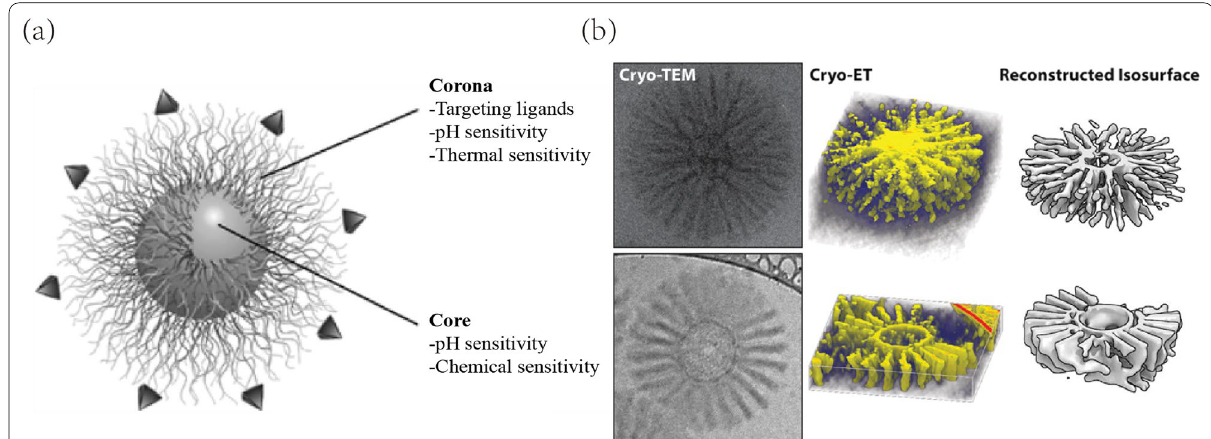
Fig. 6 a Schematic illustration of the core–shell structure of a polymer micelle. b Cryogenic transmission electron microscopy (cryo-TEM), tomography (cryo-ET) and computational 3D reconstruction of multicompartment micelles. Referred from [135, 136] respectively with